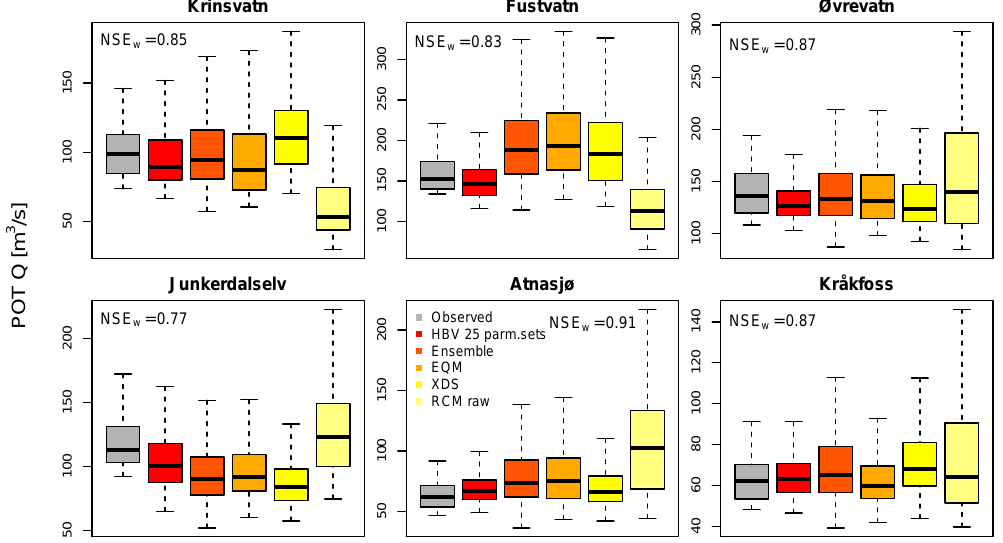
Figure 2. The distributions of POT events for the reference period from observed (grey) and simulated streamflow series generated by the calibrated HBV model using (from left to right) (i) observed climate data with the 25 best-fit parameter sets, (ii) the entire ensemble (i.e. all GCM/RCM combinations, LAMs, and hydrological parameter sets), (iii) the data locally adjusted by EQM, (iv) the data locally adjusted by XDS, and (v) the raw RCM data. For the simulations (iii–v) only one best-fit HBV parameter set is considered. The NSE w values given for each catchment represent the goodness of fit of the HBV model for the entire series (not only POT events) using the best parameter set identified by the calibration. Note that the ordinate’s point is not 0 and differs between the single plots.